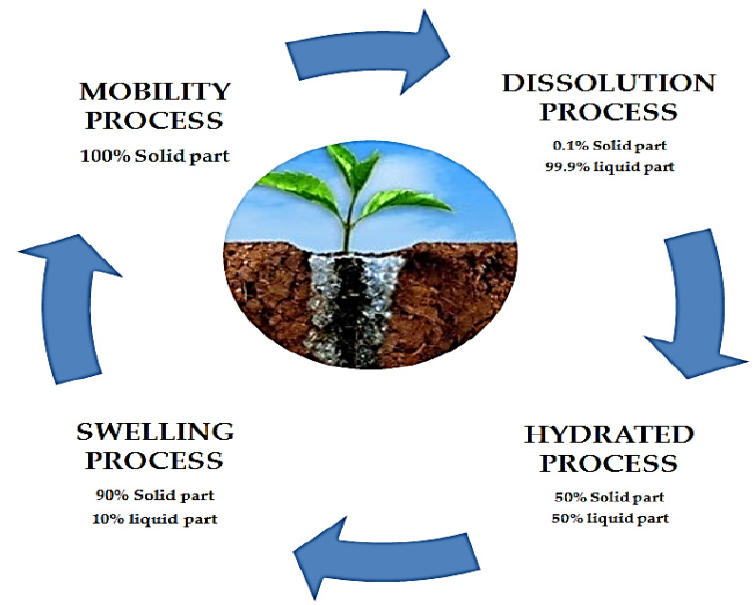
Figure 1. Hydrogel swelling process.